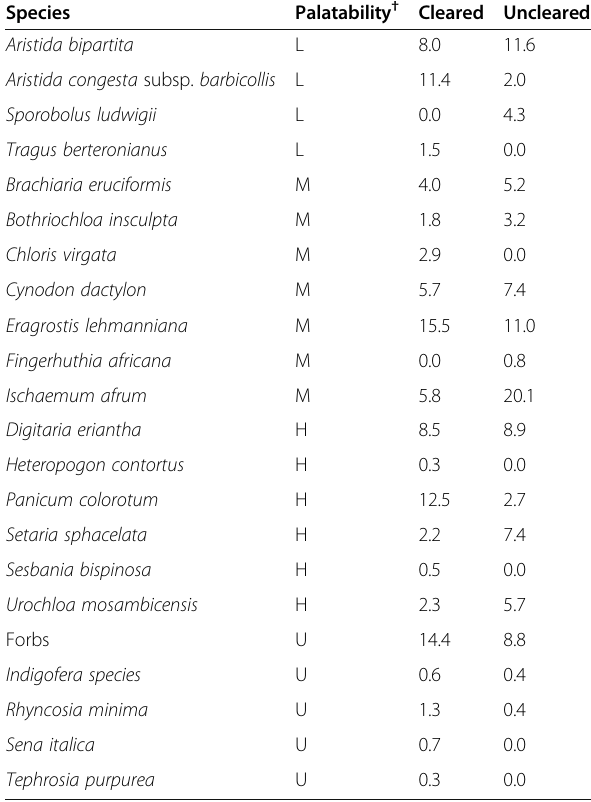
Table 2 Percent (%) contribution of herbaceous species to total biomass production in cleared and uncleared sites